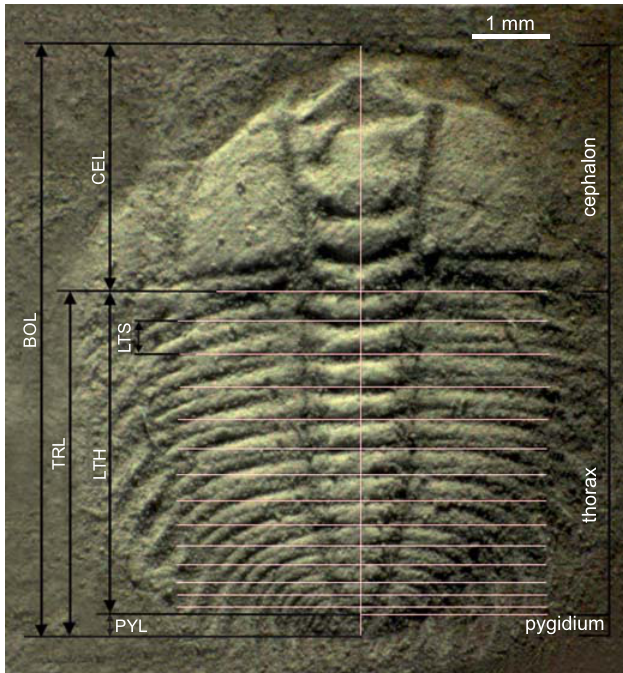
Fig. 2. Major anterior-posterior body divisions measured on oryctocephalid trilobite Changaspis elongata Lee in Chien, 1961 (D14 with 14 thoracic segments, JLZ-160-1006). A line along the sagittal axis was constructed on the image of each specimen and for each segment a line was then placed transversely to this, linking the articulating processes at the fulcral boss (the point abaxially marginal to the fulcrum). The intersections of these lines with the sagittal axis were used to calculate the length of each thoracic seg- ment i (LTS i ). LTS 2 is shown as an example. Thorax plus pygidium together constitute the trunk. Cephalon, thorax and pygidium make up the